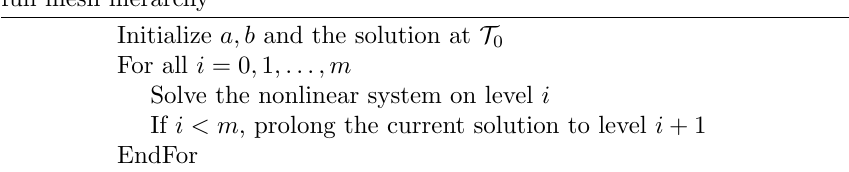
Algorithm 1 Constructing an initial guess for the nonlinear solver using the full mesh